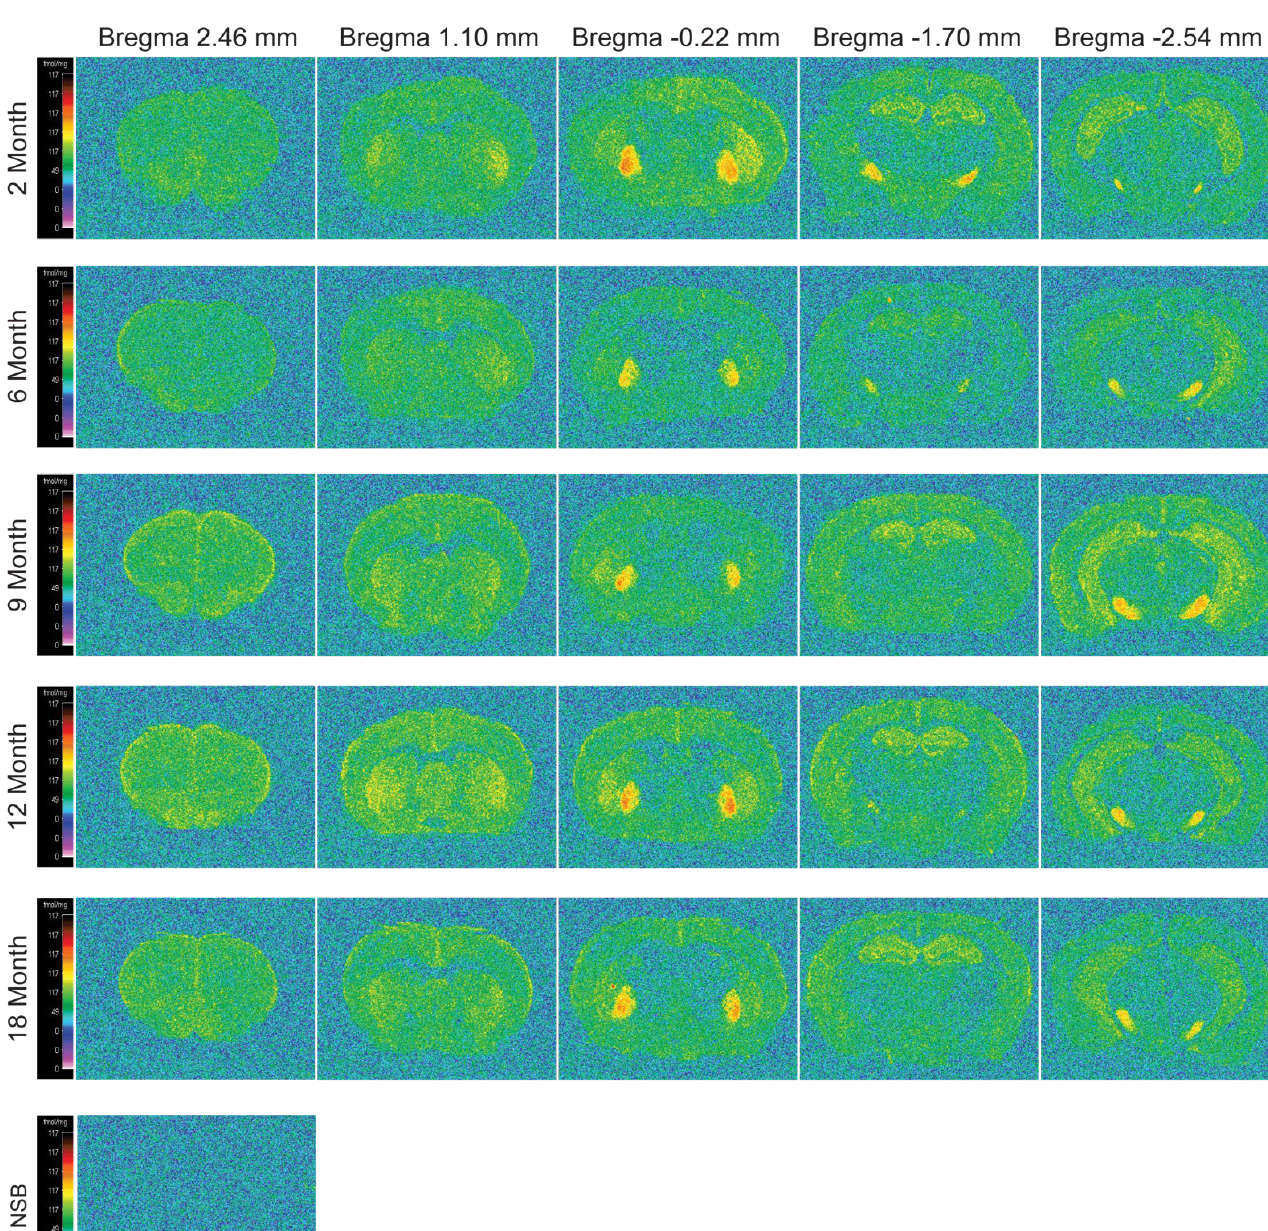
Figure 5. Computer-enhanced color autoradiograms of [ 3 H] CP55940 (10nM) binding to CB1 receptors in coronal brain sections of 2-, 6-, 9-, 12- and 18-month-old C57BL/6J mice. Coronal brain sections are represented at the level of the prelimbic cortex (column 1; Bregma +2.46 mm), striatum (column 2; Bregma +1.10 mm), lateral geniculate nucleus (column 3; Bregma − 0.22 mm), hippocampus (column 4; Bregma − 1.70 mm) and lateral entorhinal cortex (column 5; Bregma − 2.54 mm). Adjacent sections were incubated with 10 μm CP55940 to determine non-specific binding (NSB). Binding levels are represented using pseudo-color interpretation of black and white film images in fmol/mg of tissue equivalent.